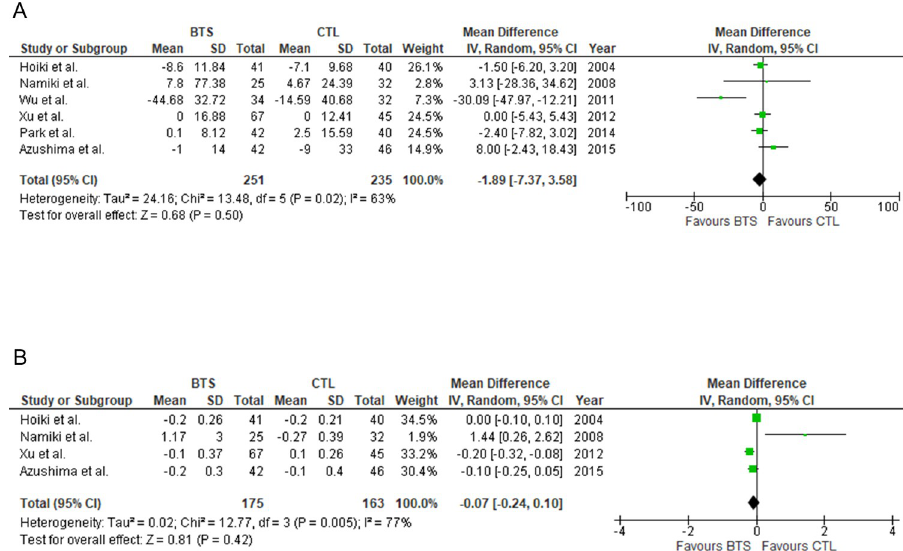
Fig 4. Meta-analysis of the effects of BTS on glucose metabolism parameters. (A) Free blood glucose. (B) Glycohemoglobin. BTS, bofutsushosan group; CTL, control